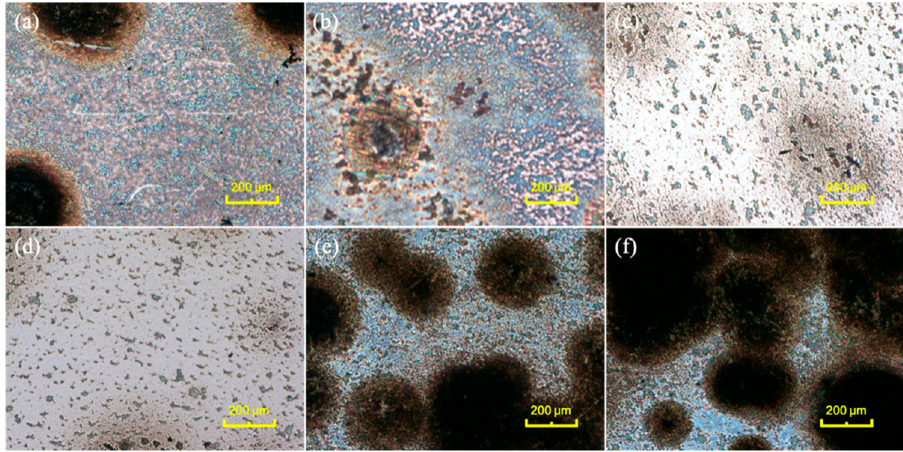
Figure 4. Surface optical microscopy images of the MXene coatings fabricated under different conditions: ( a ) 4 mg/mL, 1 layer; ( b ) 2 mg/mL, 1 layer; ( c ) 1 mg/mL, 1 layer; ( d ) 0.5 mg/mL, 1 layer; ( e ) 4 mg/mL, 2 layers; ( f ) 4 mg/mL, 3 layers.